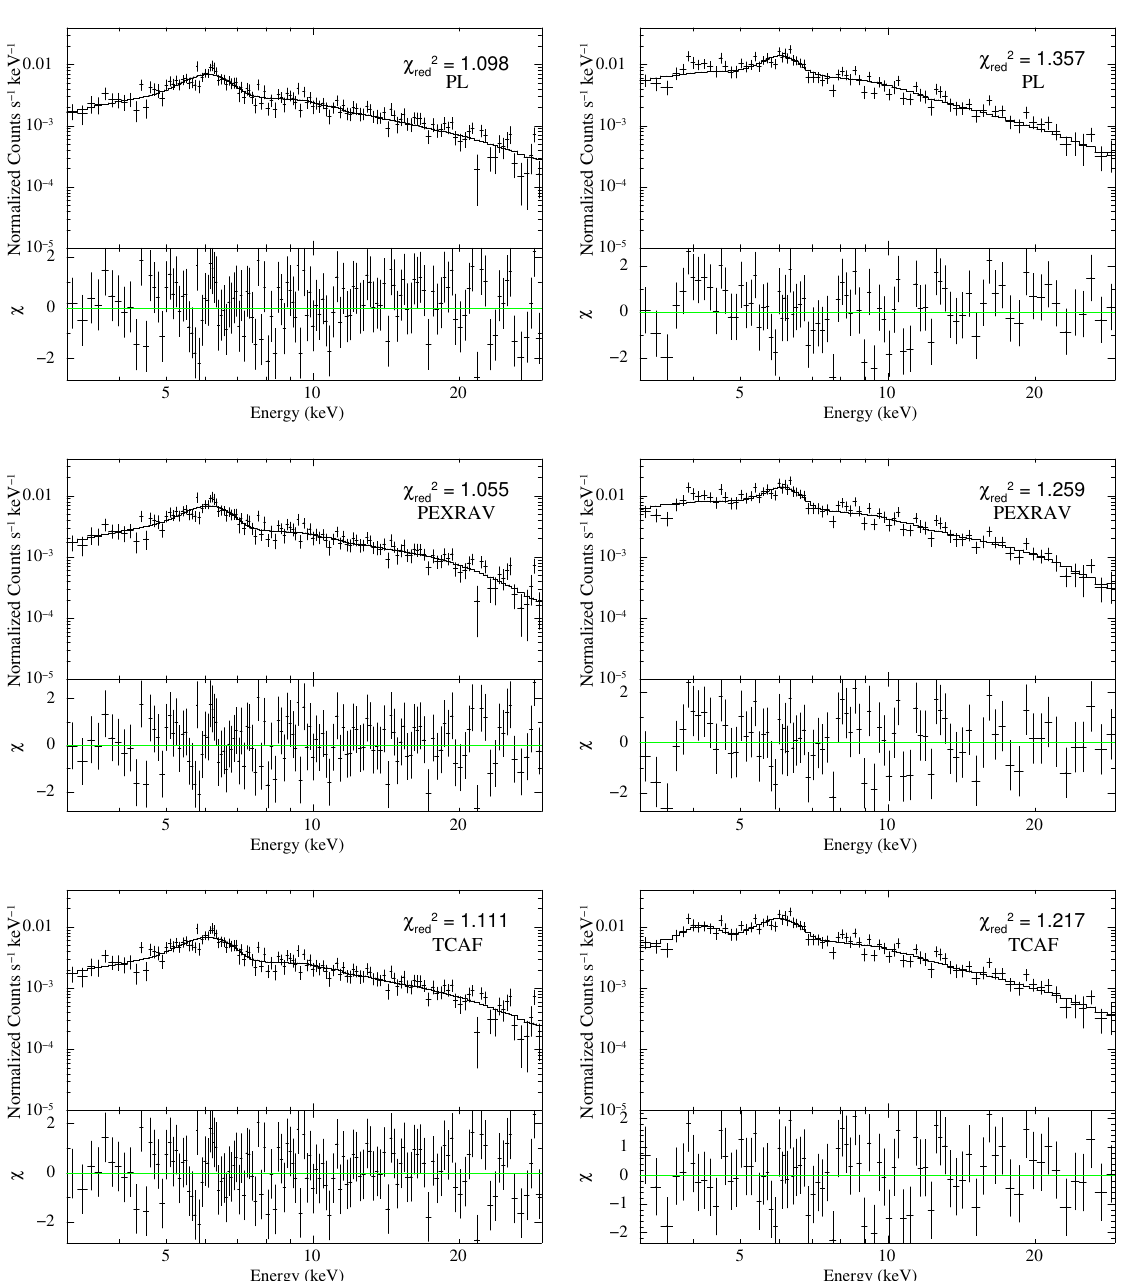
Figure A1. Same as Figure 2 but for the OBSIDs 80201001002 ( left panel ) and 90602619004 ( right panel ) along with the